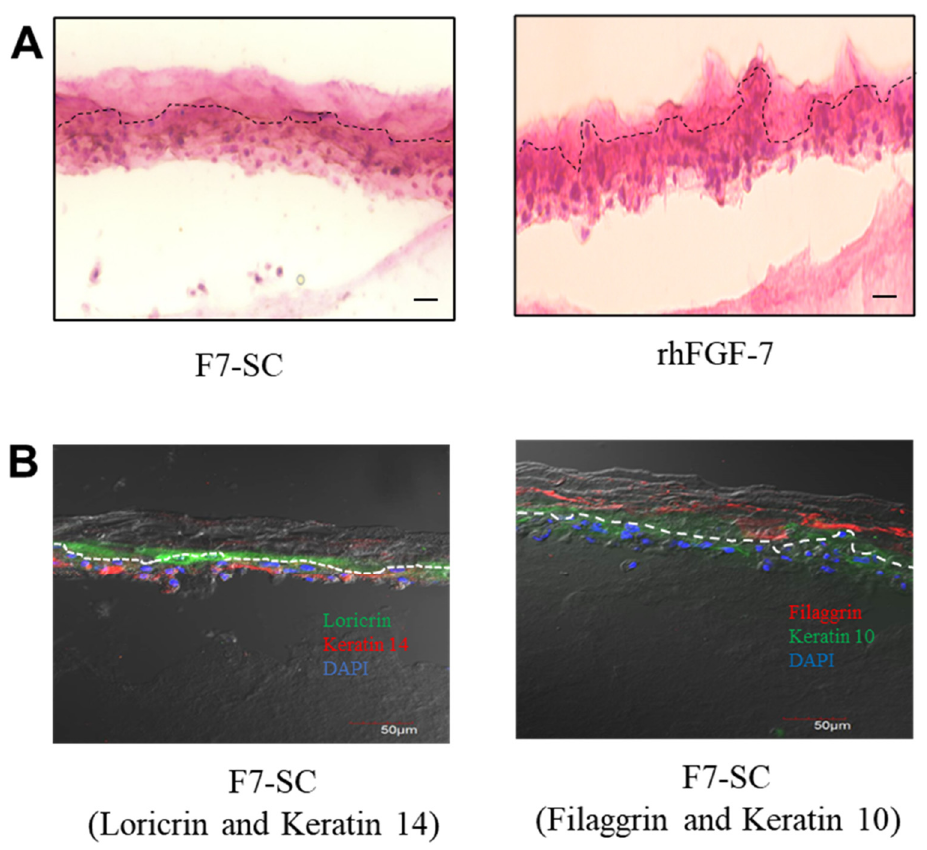
Figure 7. Three-dimensional (3D) cultivation and differentiation of NHEK cells. NHEK cells were cultivated for 2 days on collagen gel under a submerged condition and continued to grow at the air–liquid interface in a medium containing 1.2 mM Ca 2+ with regular medium change until day 14. The 3D-cultivated cell culture was cryo-sectioned for analysis. ( A ) Hematoxylin and eosin (HE) staining of NHEK cells 3D-cultured (left panel) on collagen gel containing 800 µ g of F7-SC powder or (right panel) using basal medium supplemented with 300 ng of rhFGF-7. Scale bar, 20 µ m. ( B ) Immunofluorescent staining for expression of differentiation markers on NHEK cells 3D-cultured on collagen gel containing F7-SC powder. Detection of (left panel) loricrin and keratin 14 and (right panel) filaggrin and keratin 10. Nuclei were stained with 4 (cid:48) ,6-diamidino-2-phenylindole (DAPI). Upper layer above the dashed line shows the speculated stratum corneum. Scale bar, 50 µ